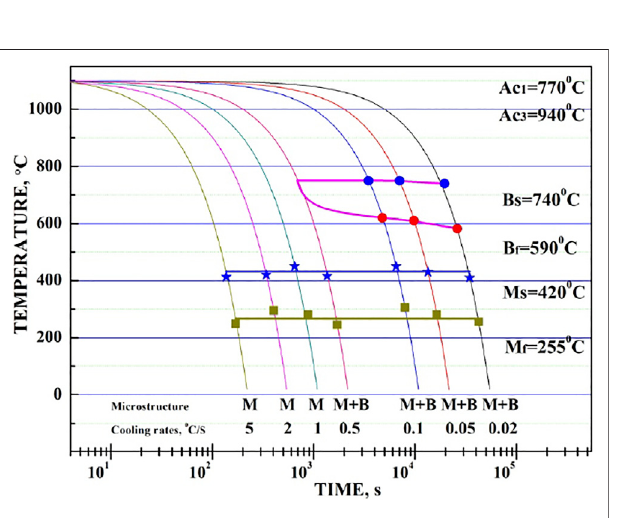
FIGURE 8 | CCT diagram of NSM steel, containing both bainite and martensite transformation when cooled down at a rate below 0.1 ° C/s, while only martensite transformation when beyond 0.5 ° C/s.